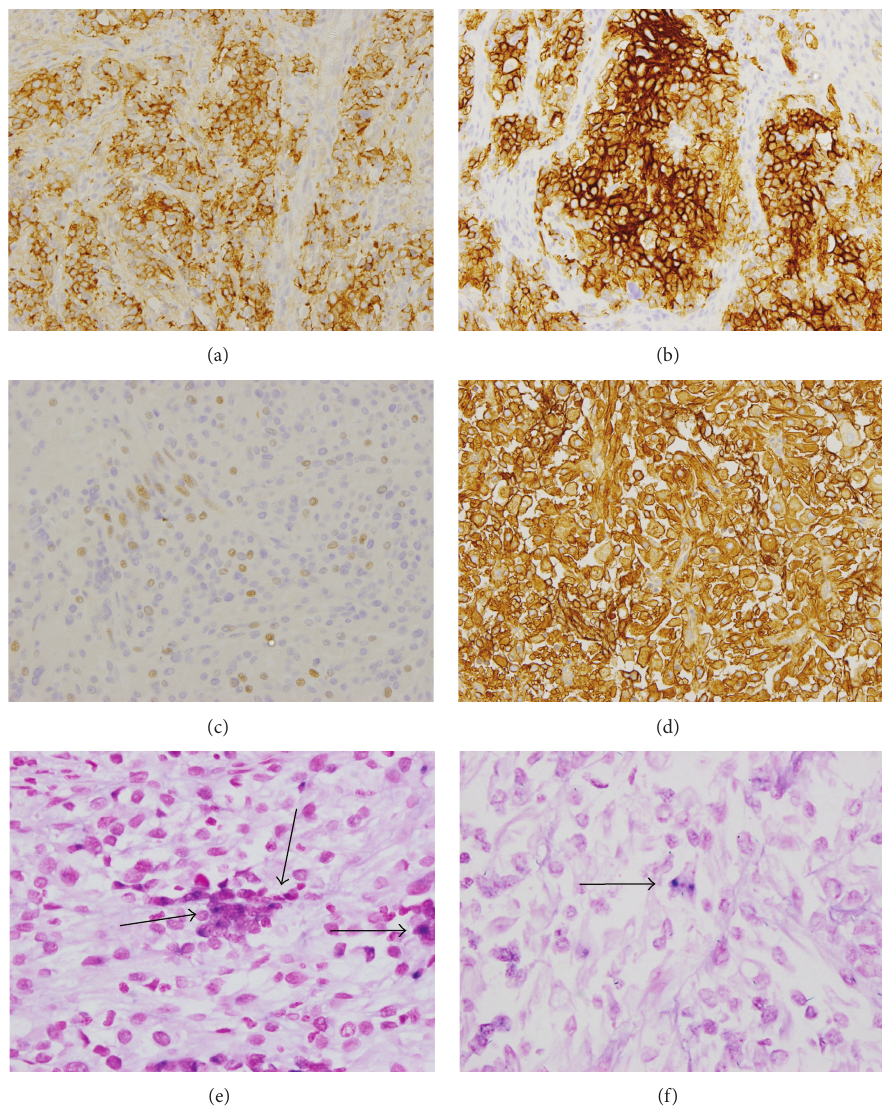
Figure 3: Immunohistochemical findings. Cells in component A showed positive staining for (a) synaptophysin and (b) CD56. Cells in component B were positive for (c) myogenin and (d) CD56. In situ hybridization for HPV type 16/18 showed dot-like staining consistent with viral integration pattern in the nuclei (arrow) of (e) component A and (f) component B (original magnification × 20 for (a)–(d) and × 40 for (e) and